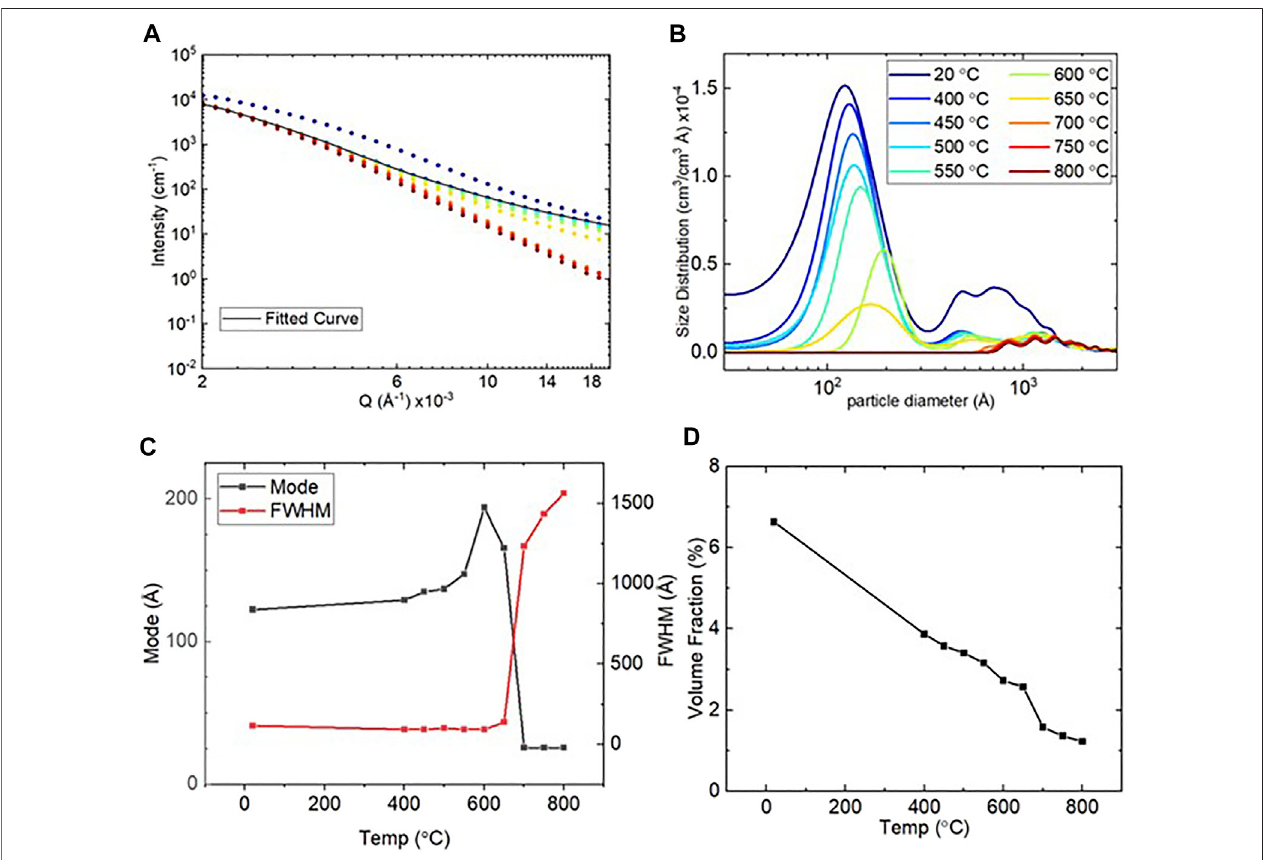
FIGURE 2 | (A) The 1D (SANS) for Al 1.3 CoCrCuFeNi and the size distribution analysis. (B) Size distribution from the IRENA size distribution tool. (C) Trends in the data of the size distribution of mode and full-width at half maximum (FWHM). (D) Volume fraction as